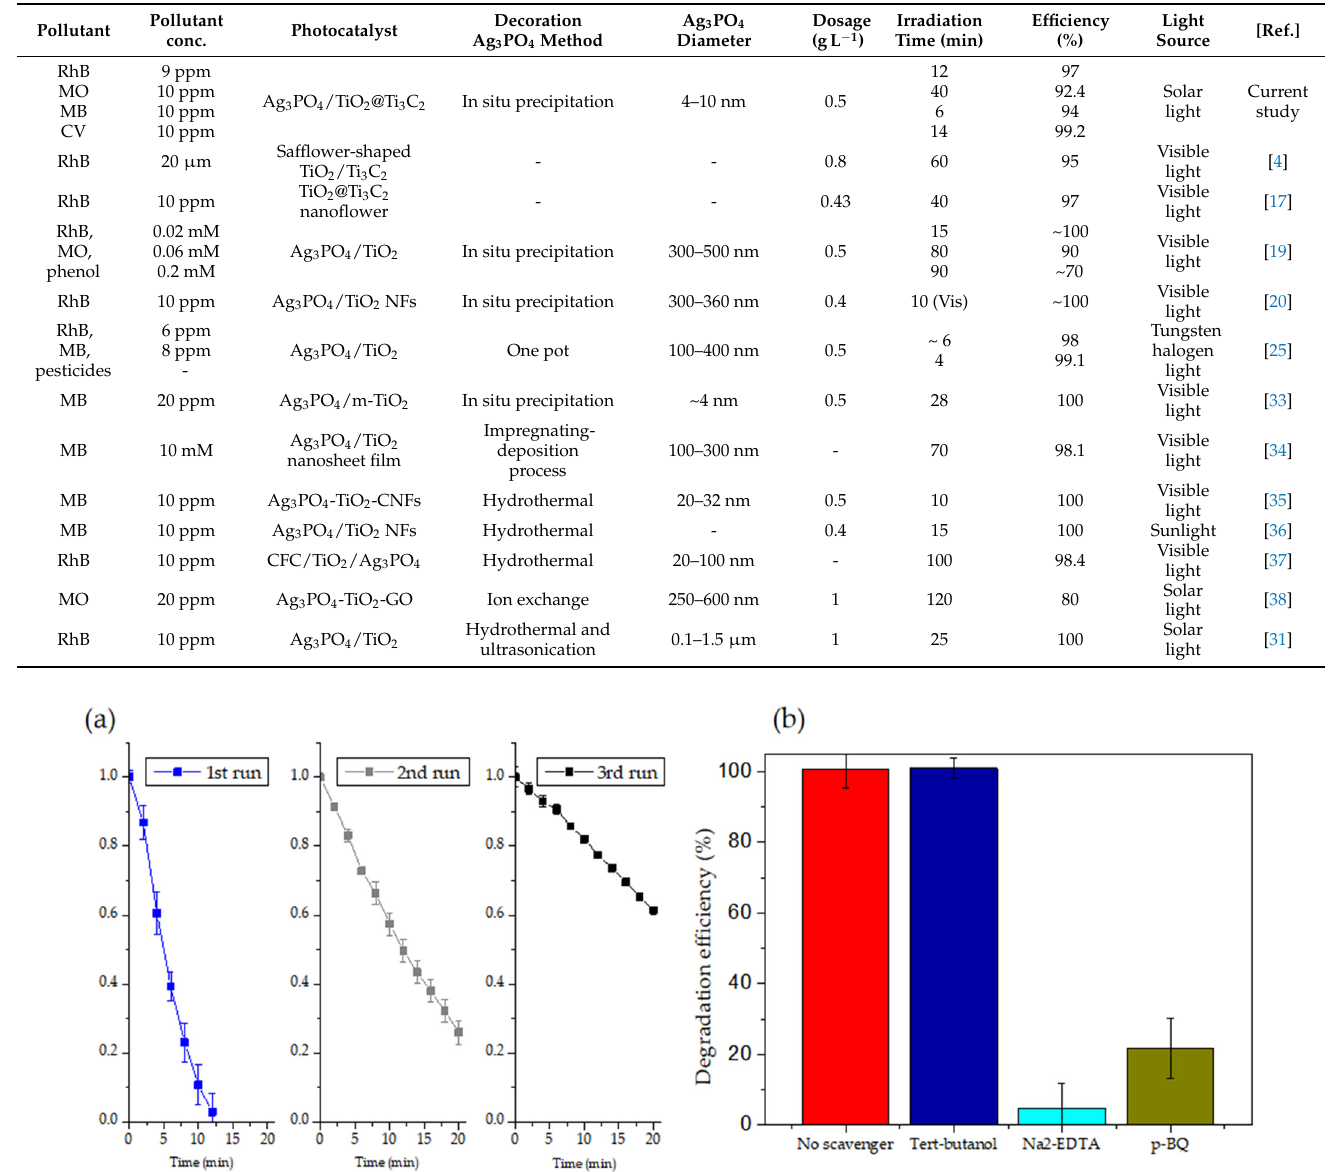
Figure 9. ( a ) Effects of scavengers on the RhB photodecomposition. ( b ) The stability of Ag 3 PO 4 /TiO 2@ Ti 3 C 2 (A4) after three consecutive recycling runs. TiO 2@ Ti 3 C 2 (A4) after three consecutive recycling